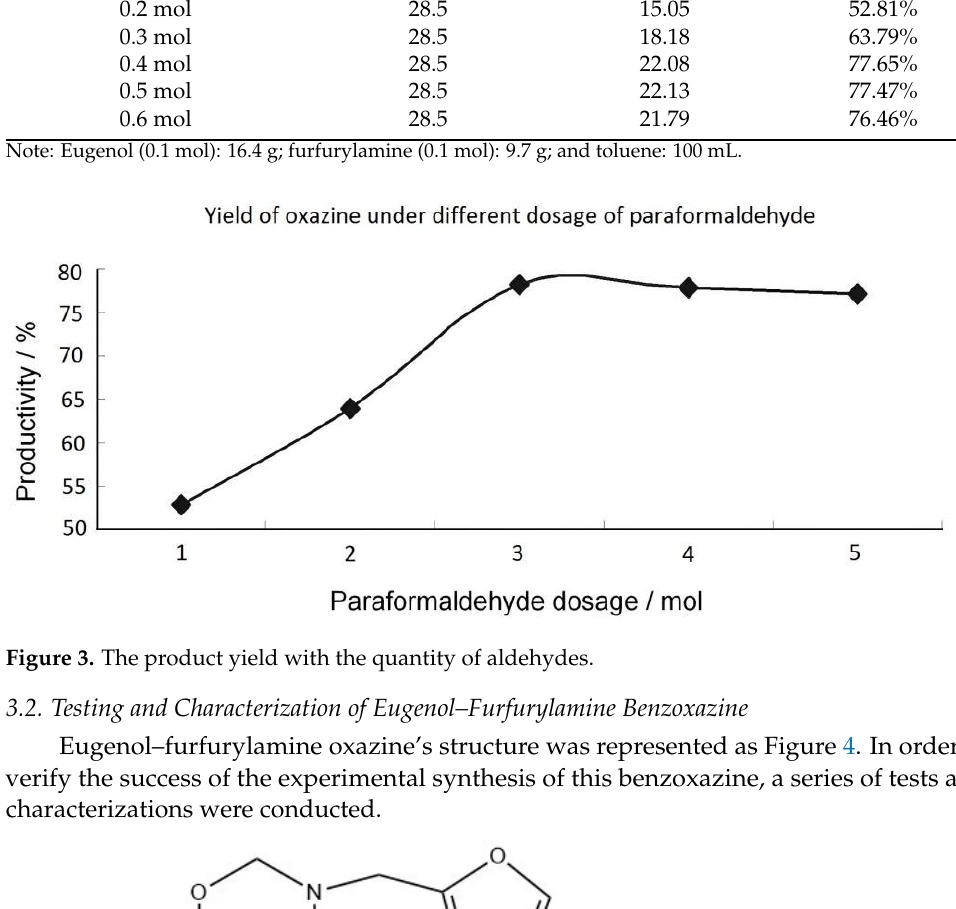
Table 3. The product yield with the quantity of aldehydes. Paraformaldehyde Theoretical Yield/g Actual Yield/g Dosage